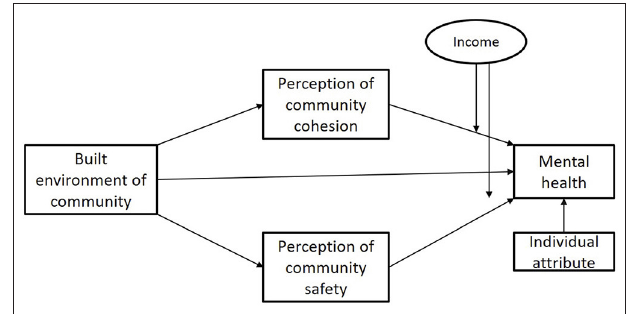
FIGURE 1 | Research